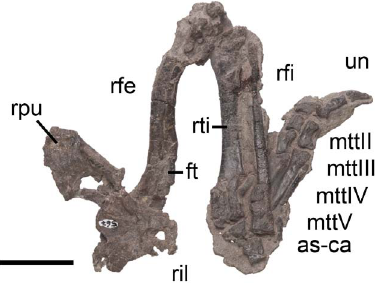
Figure 12. Right hindlimb of Pseudochampsa ischigualastensis (PVSJ 567) in anterior view. Abbreviations: as-ca, astragalus-calcaneum; ft, fourth trochanter; mttII–V, metatarsals II–V; rfi, right fibula; rfe, right femur; ril, right ilium; rti, right tibia; un, ungueal. Scale bar equals 5